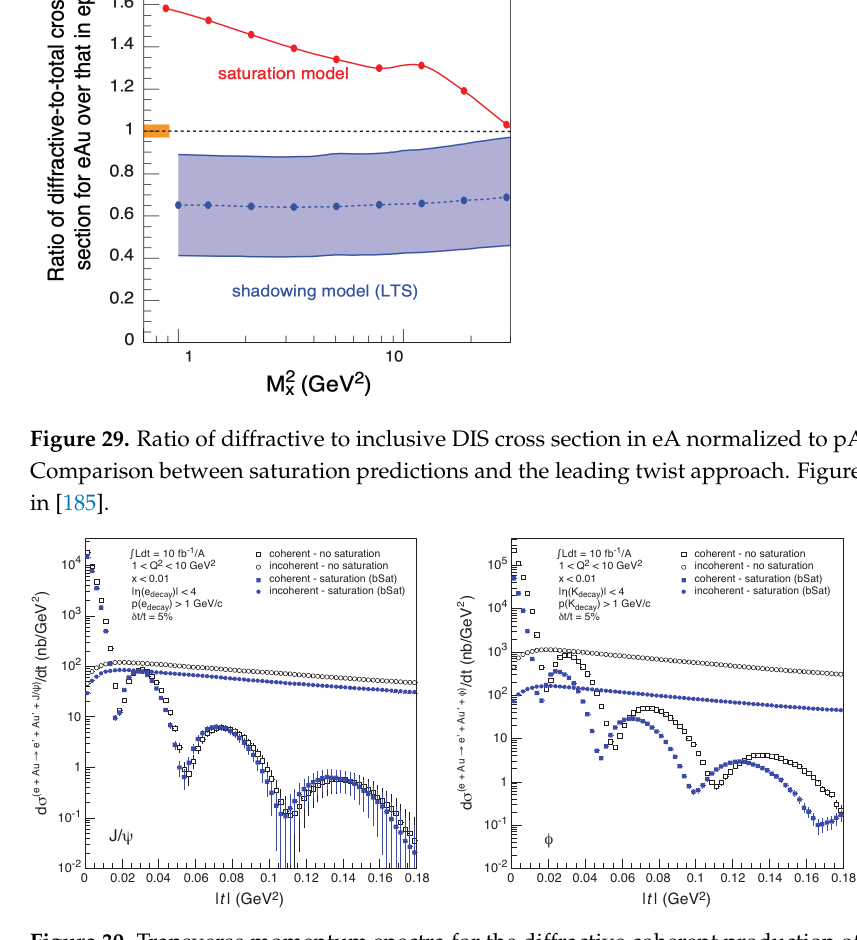
Figure 30. Transverse momentum spectra for the diffractive coherent production of vector mesons in electron-gold ion collisions. ( Left ) J / ψ production. ( Right ) ρ production. The figures show the comparison between models with and without saturation. Figure from the work in